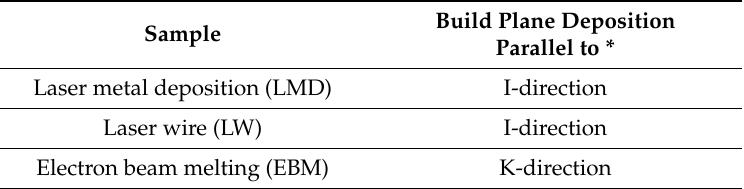
Figure 5. Typical dynamometer force readings.